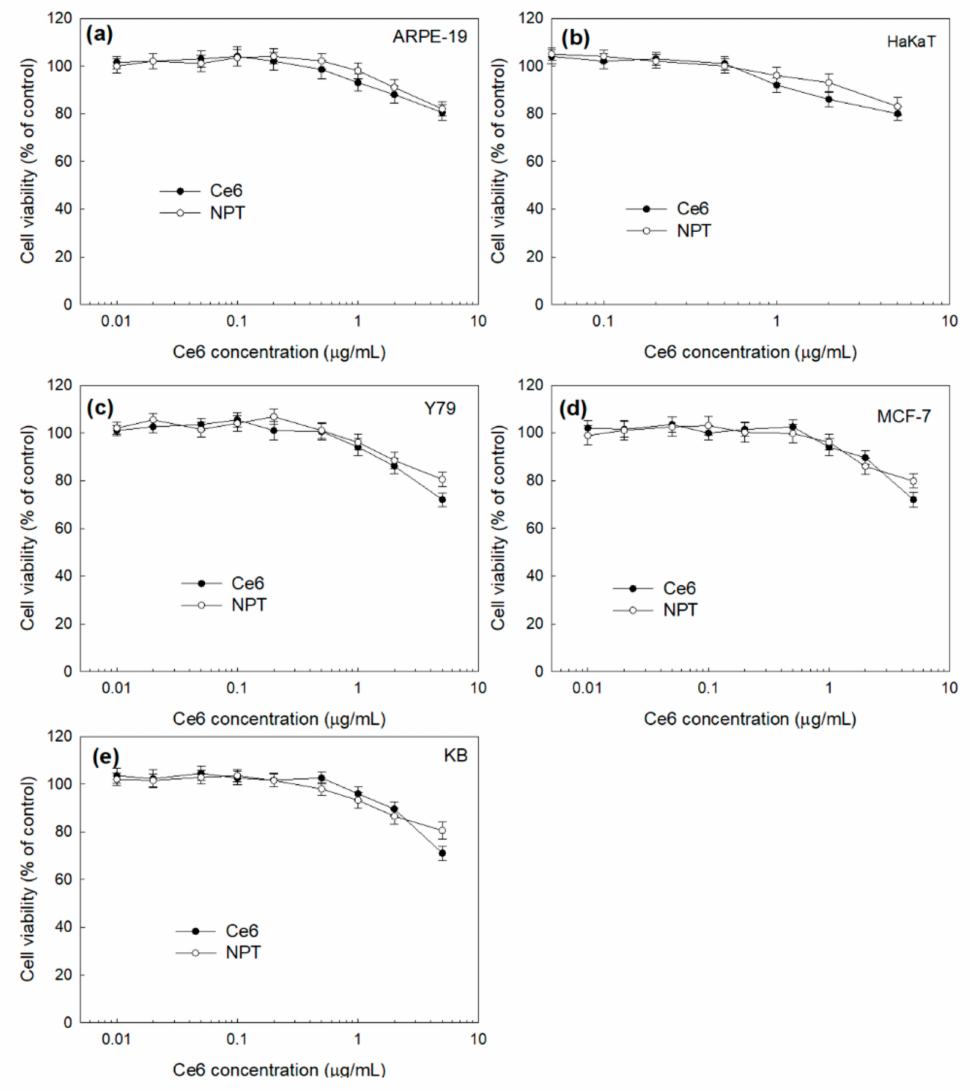
Figure 6. Dark toxicity of free Ce6 and nanophotosensitizers, with normal cell lines such as ARPE-19 cells ( a ) and HaKaT cells ( b ) and cancer cell lines such as Y79 cells ( c ), MCF-7 cells ( d ) and KB cells ( e ). NPT = FAPEGtaCe6